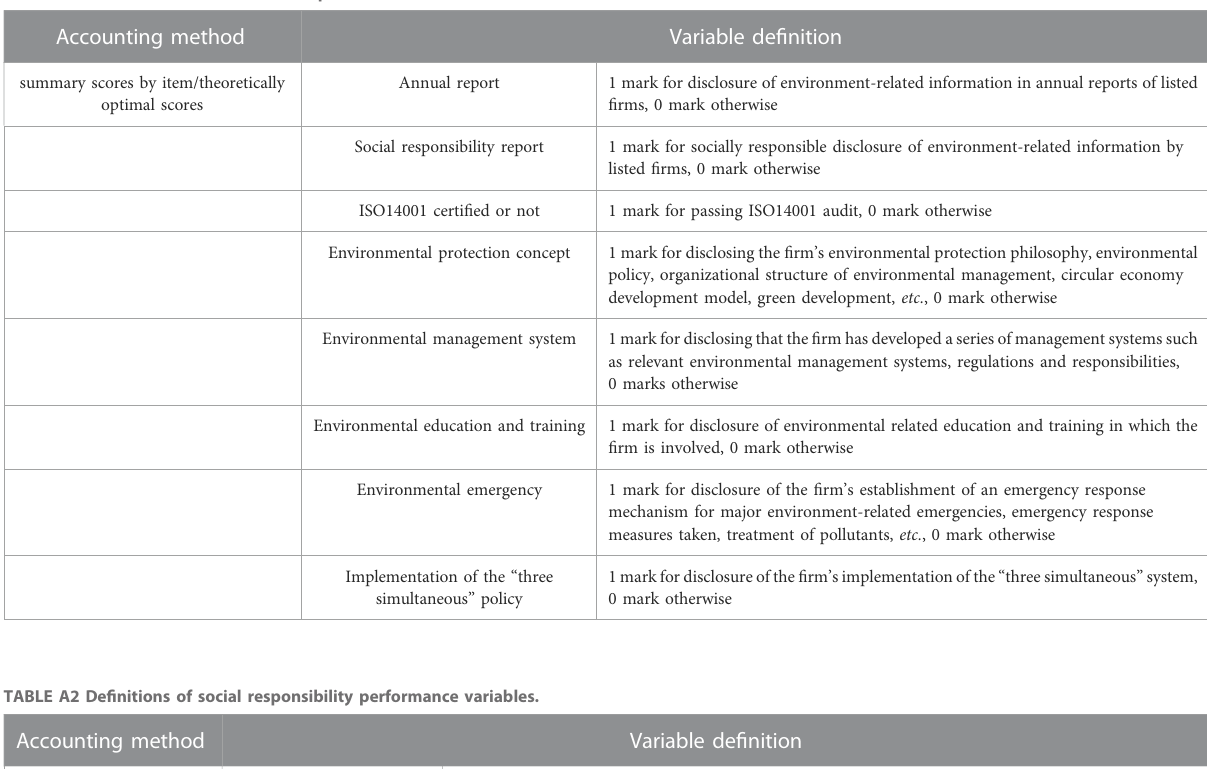
TABLE A1 De fi nitions of environmental performance variables.